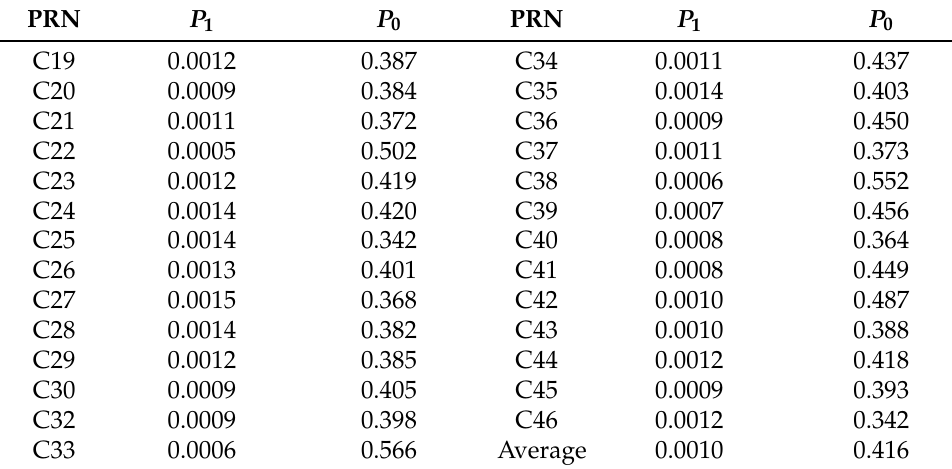
Figure 5. The BRCO errors increase with time. Table 1. The fitting result of the BRCO